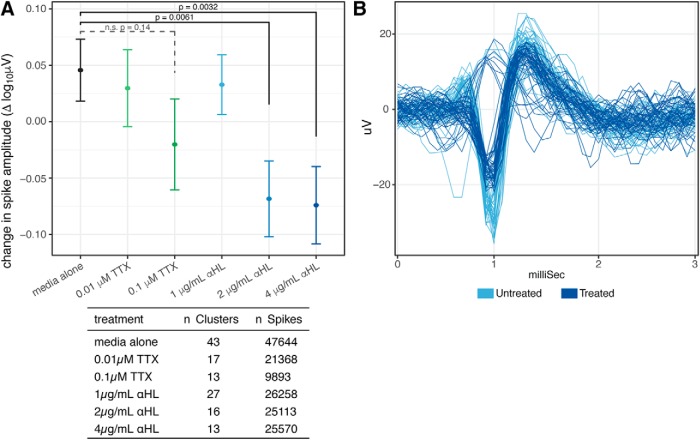
Change in wave form amplitude following treatment with pore-forming toxin. A, Estimated of change in spike wave form amplitude (Δlog10 μV) of spike clusters within cortical cultures treated with titration of TTX (green) or αHL (blue), across untreated (0 h) and treated (24 h) recordings. Treatment of 22–39 replicate wells per condition across four experiments. Data presented as mean ± SE Hz obtained from LME model of wave form amplitude as function of treatment and recording. Differences in wave form amplitude assessed by general-linear hypothesis test, significance indicated by brackets and associated p values. Table indicates number of spike clusters, and spike events available for analysis in each condition. B, Comparison of waveforms within spike cluster demonstrating the largest change in amplitude (μV) among the 4 μg/ml αHL treatment condition. Sample of 50 waveforms per recording shown, untreated (light blue) and treated (dark blue).